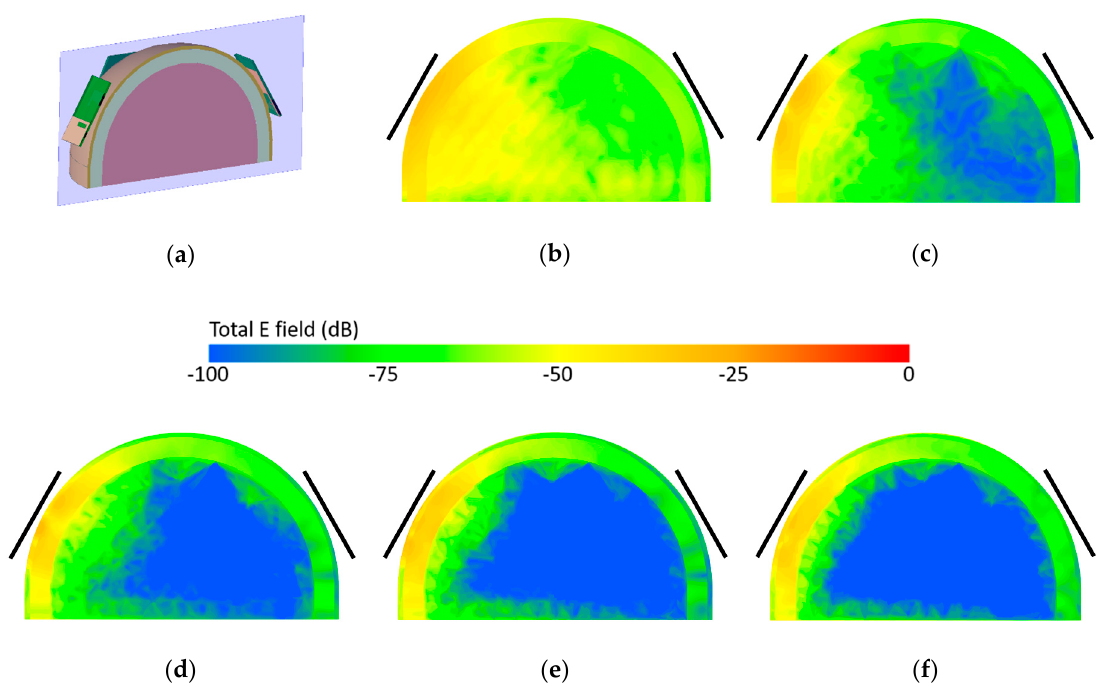
Figure 20. Field distribution inside the breast model for different frequencies when Antenna 1 is transmitting: ( a ) Evaluated model; ( b ) 3 GHz; ( c ) 5 GHz; ( d ) 7 GHz; ( e ) 9 GHz; ( f ) 11 GHz.